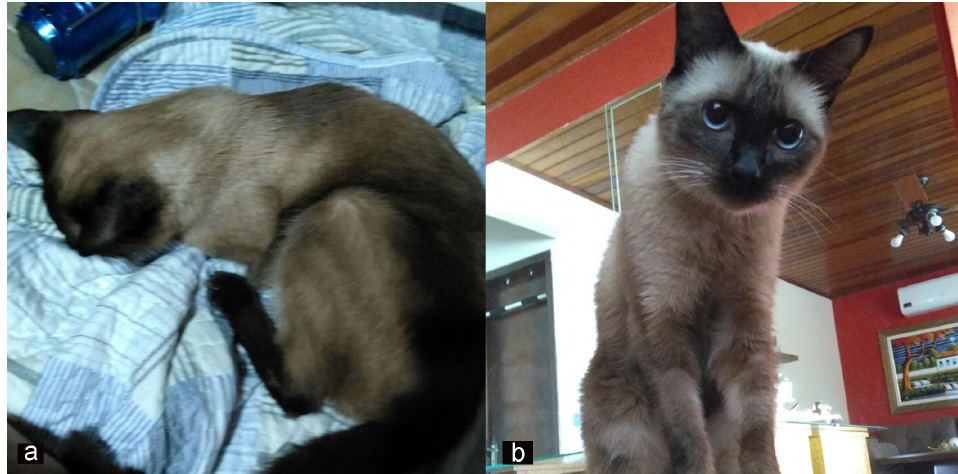
Figura 5. Foto do paciente antes e após o tratamento. (a) Paciente prostado no momento do diagnóstico; (b) Paciente em casa após o tratamento em estado compensado.